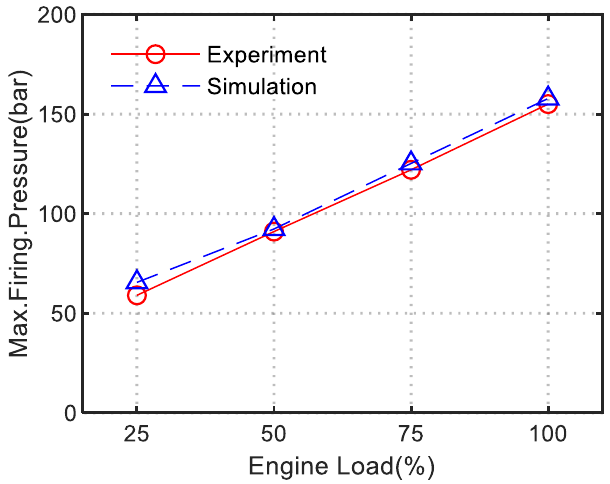
Figure 7. Max.Firing.Pressure comparison between simulation and experiment.